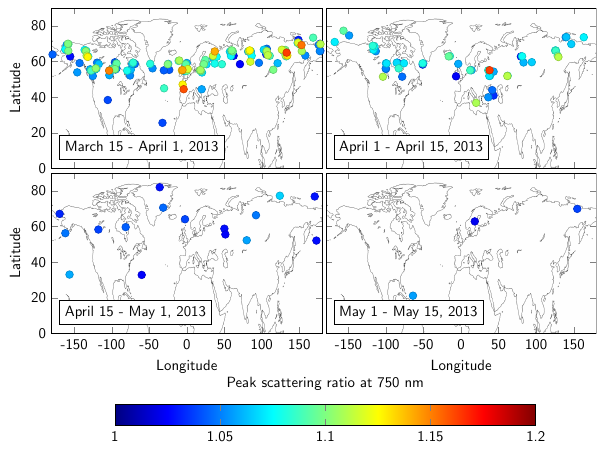
Fig. 2. Locations of scans that show meteoric enhancements. Color shows the 750nm scattering ratio at the highest peak in the